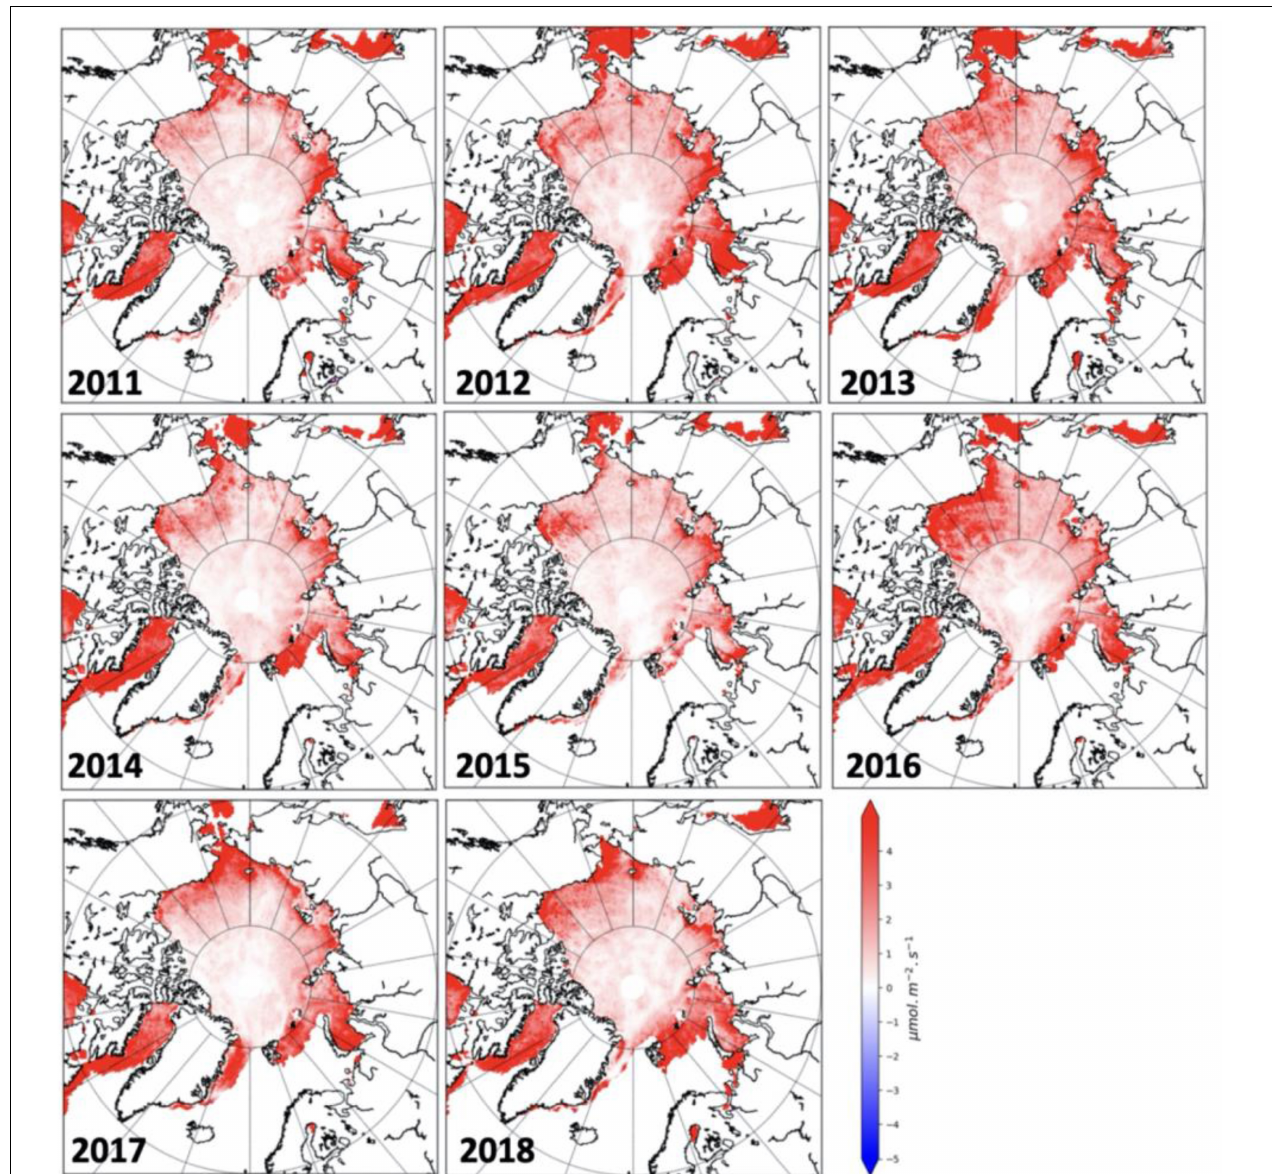
FIGURE 11 | Difference in monthly mean April PAR between using a heterogenous snow depth following Eq. 12 and assuming a mean ice thickness per grid cell versus a mean snow depth per satellite